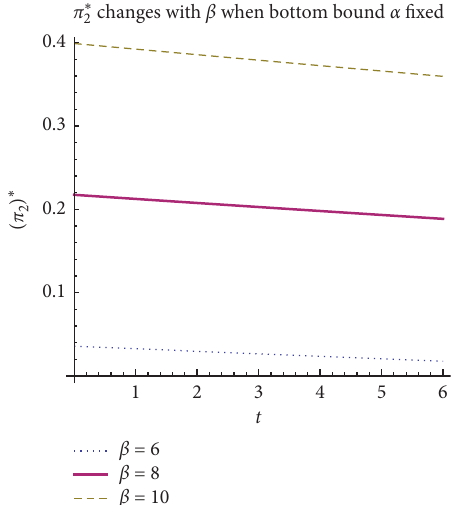
Figure 4: Values of π ∗